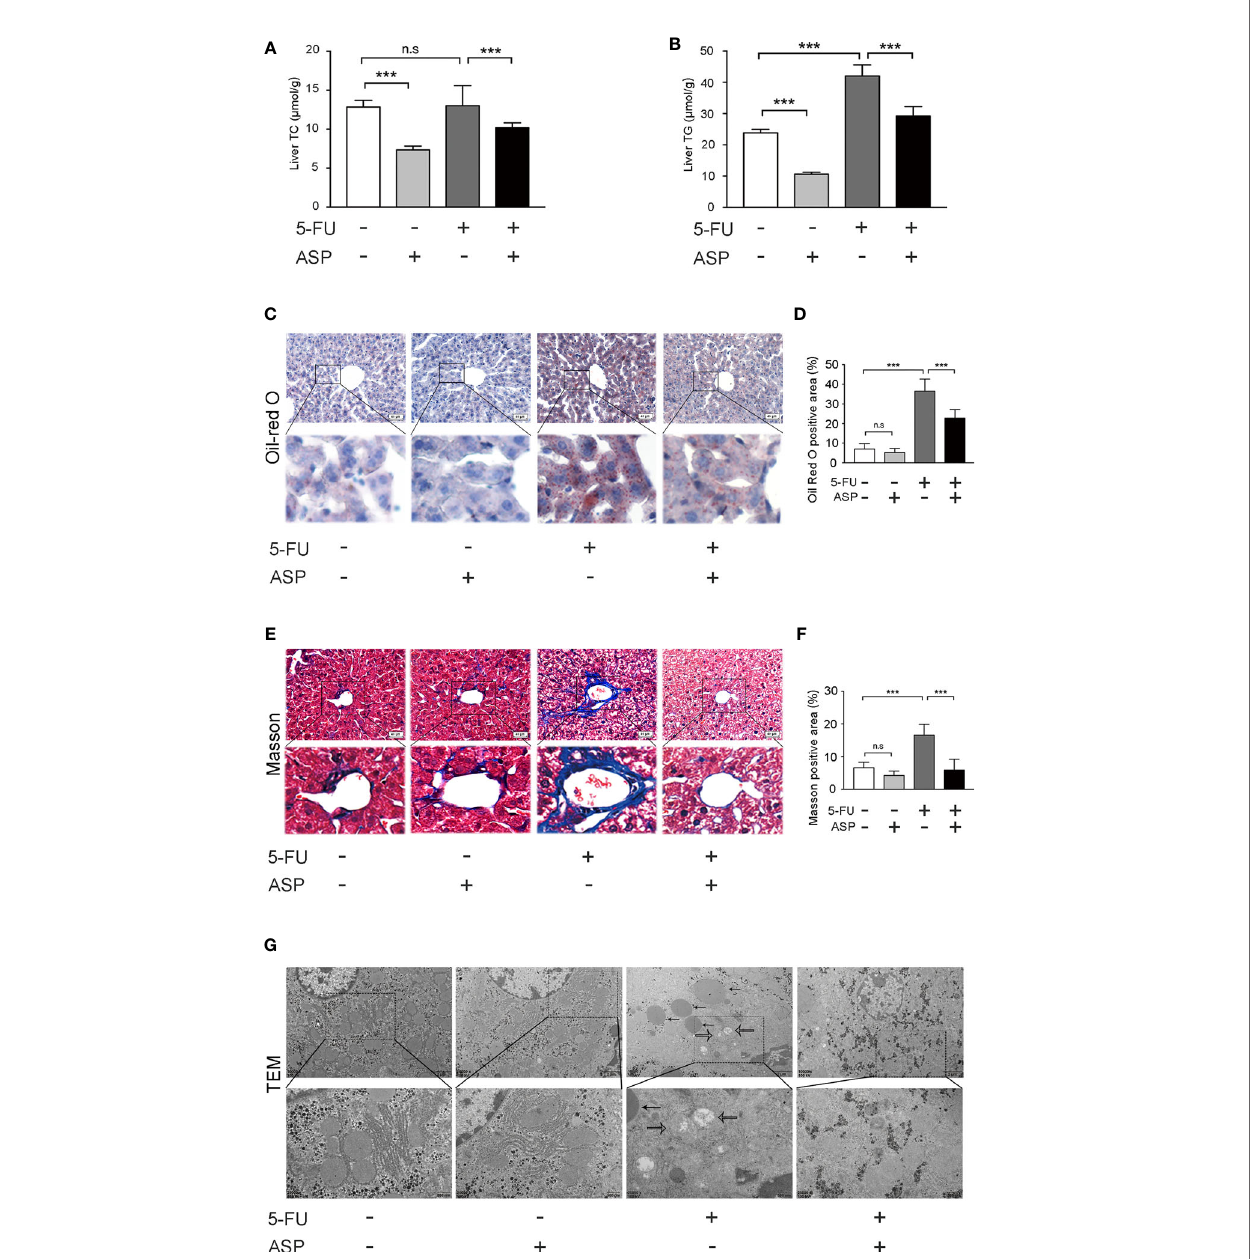
FIGURE 2 | ASP attenuated 5-FU-induced liver lipid deposition in vivo. (A) The level of TC was measured. (B) ASP treatment reversed the 5-FU-induced abnormal elevation of liver biochemical parameters and TG ( n = 6/group). (C, D) Oil Red O staining (nuclei were stained purple, and lipids were stained red). ASP rescued the lipogenesis induced by 5-FU treatment (magni fi cation, × 200, scale bar, 40 m m). Images were analyzed using ImageJ ( n = 6/group). (E, F) Masson staining of liver tissues (magni fi cation, × 200, scale bar, 40 m m). Images were analyzed using ImageJ ( n = 6/group) (G) TEM micrograph of the mice liver. The solid arrow points to the lipid droplet, and the open arrow points to the swollen mitochondria (magni fi cation, × 10000 or × 25000, scale bar, 2 m m or 500 nm, respectively). ***p < 0.001. n.s., not statistically signi fi